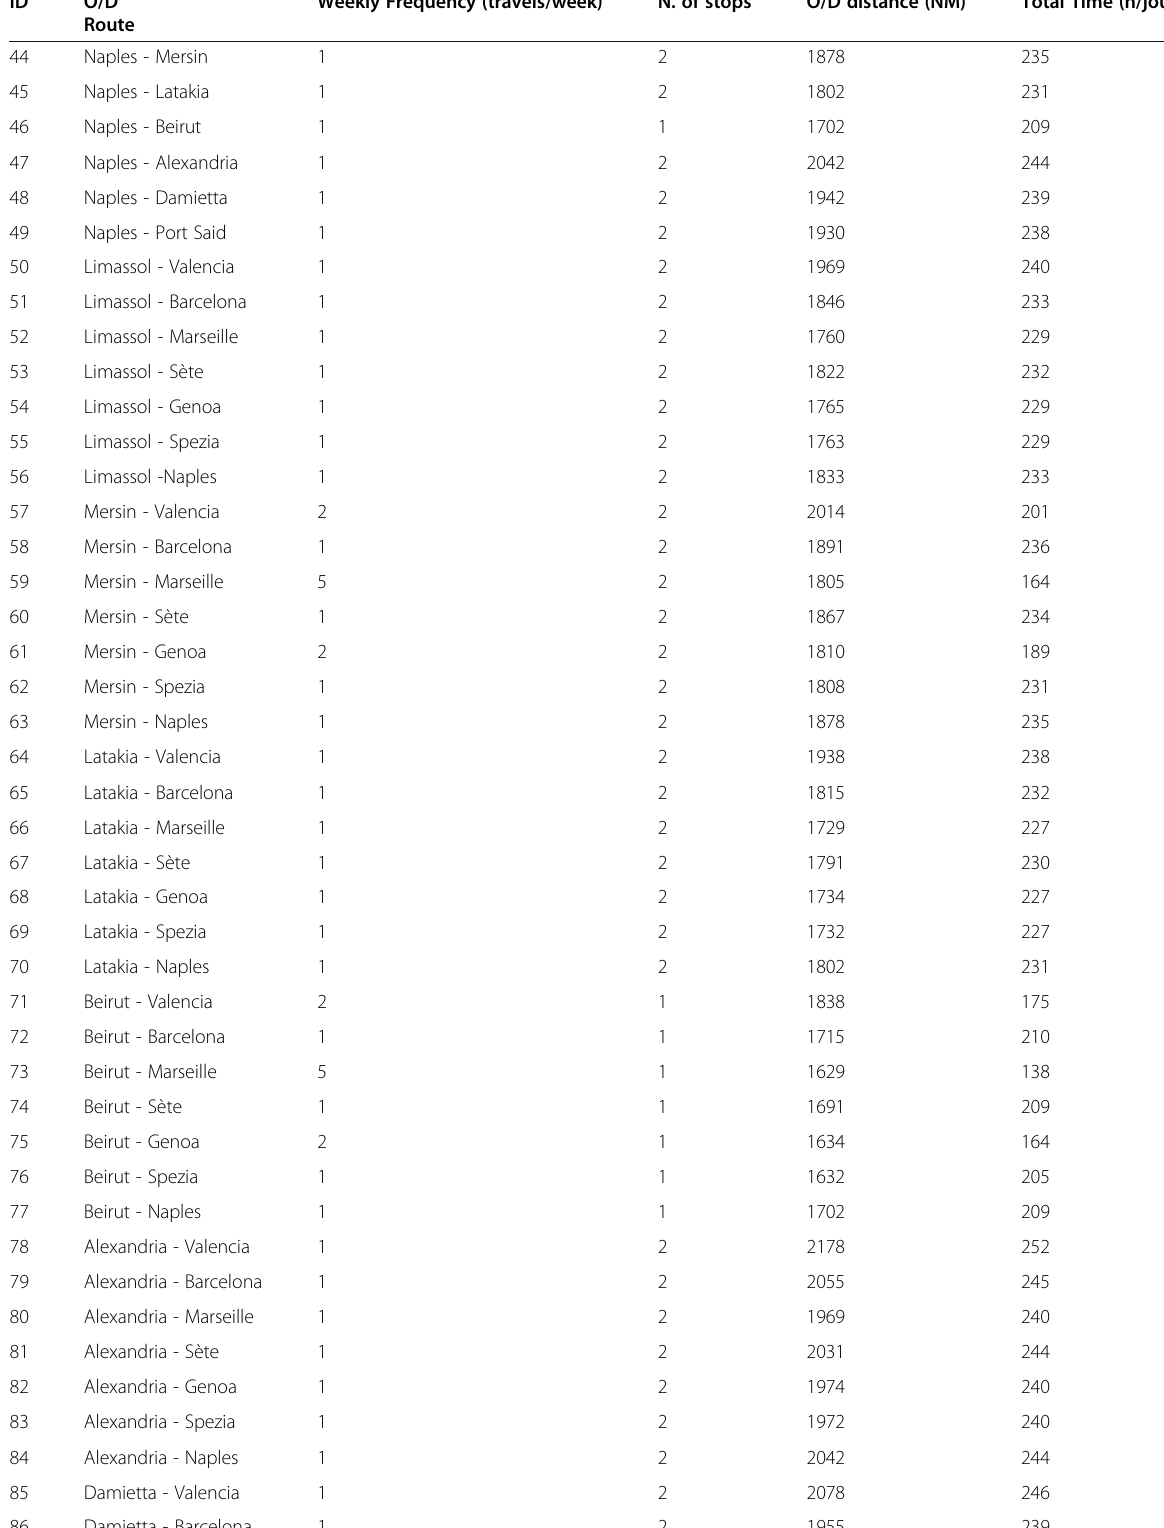
Table 23 Operational features of the optimized network